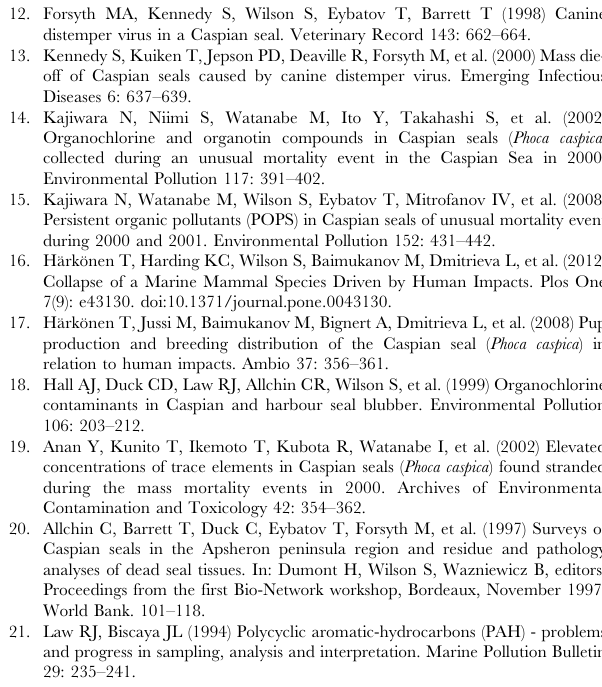
Table S2. Age, sex and body length data used to generate Caspian seal growth curves. Figure S2. Overlain data and growth curves for male (filled points, black line) and female (open triangles, grey